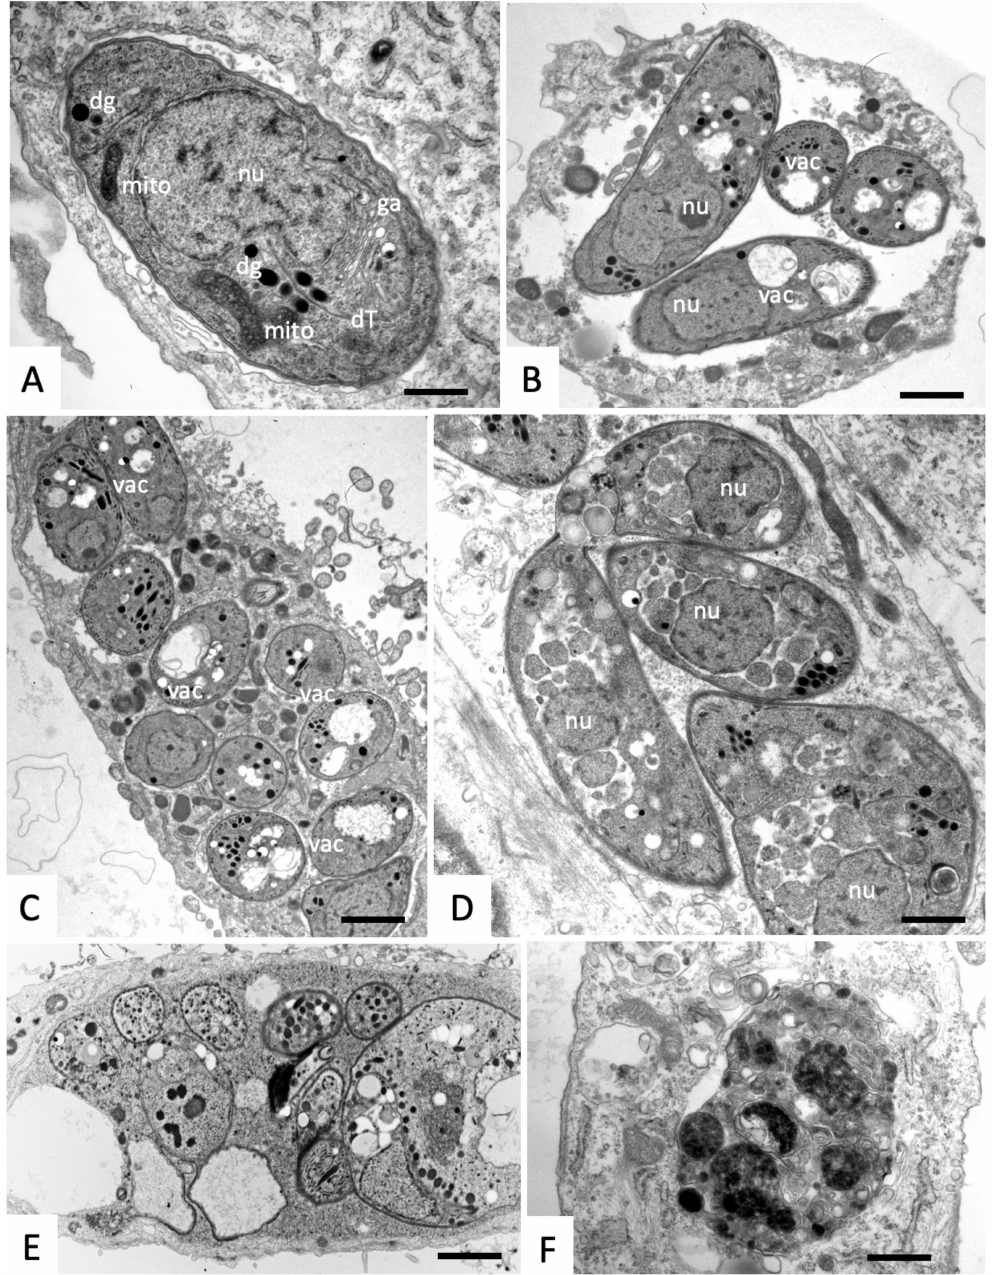
Figure 7. TEM of N. caninum tachyzoite-infected HFF treated with a 500-nM compound (5) and fixed and processed at di ff erent timepoints after the treatment began ( A , B ) = 6 h, ( C ) = 12 h, ( D ) = 24 h, ( E , F ) = 48 h). dg = dense granules, dT = daughter zoites, ga = golgi apparatus, mito = mitochondrion, nu = nucleus, vac = vacuolization. The bar in ( A ) = 0.4 µ m; ( B , C ) = 1 µ m; ( D ) = 0.6 µ m; ( E ) = 1.2 µ m; ( F ) = 0.5 µ